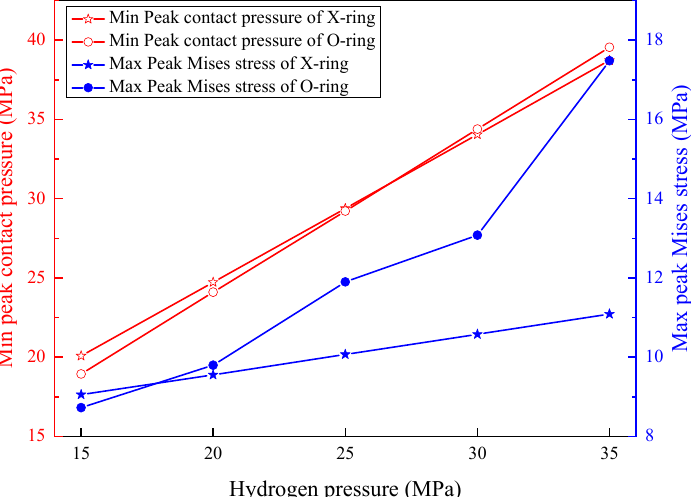
Figure 14. Min peak contact pressure and max peak Mises stress of X-ring and O-ring during 1–2 T in various P h .